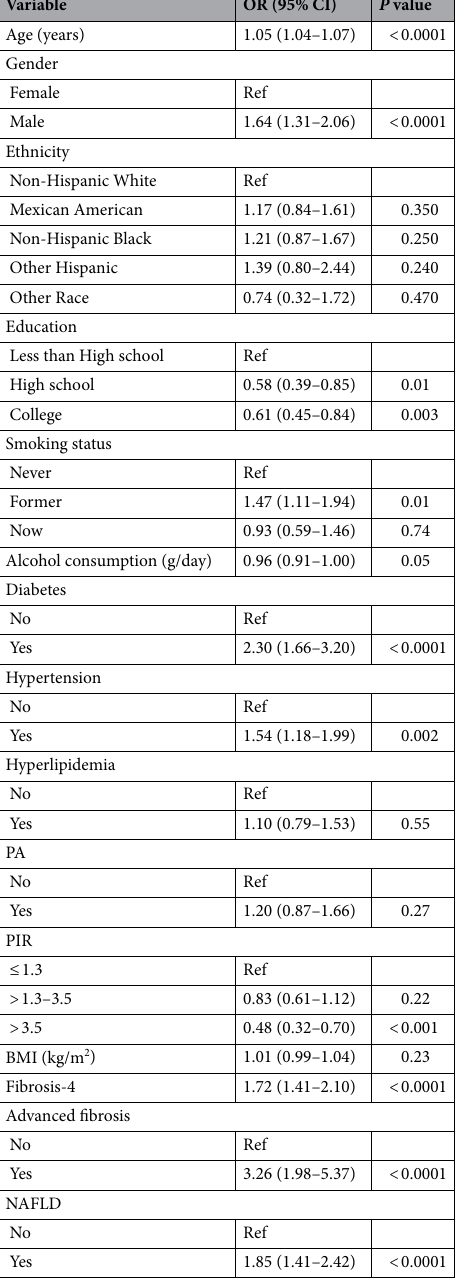
1.85 Table 2. Association between univariate and PN in logistic regression model. NAFLD non-alcoholic fatty liver disease, PN peripheral neuropathy, BMI body mass index, PIR poverty income ratio, PA physical activity, OR odds ratio, CI confidence interval, Ref reference.